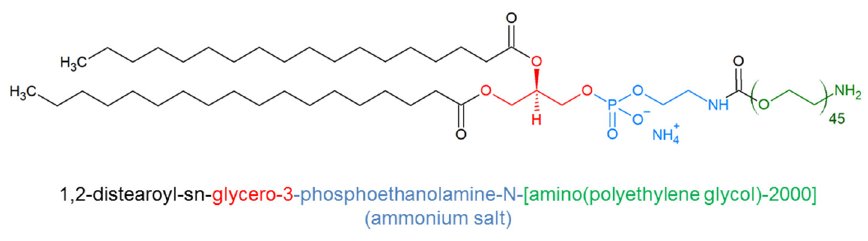
Figure 7. Chemical structure of DSPE-PEG(2000). Zhang et al. stitched cRGDfK to DSPE-PEG, obtaining self-assembled micelles